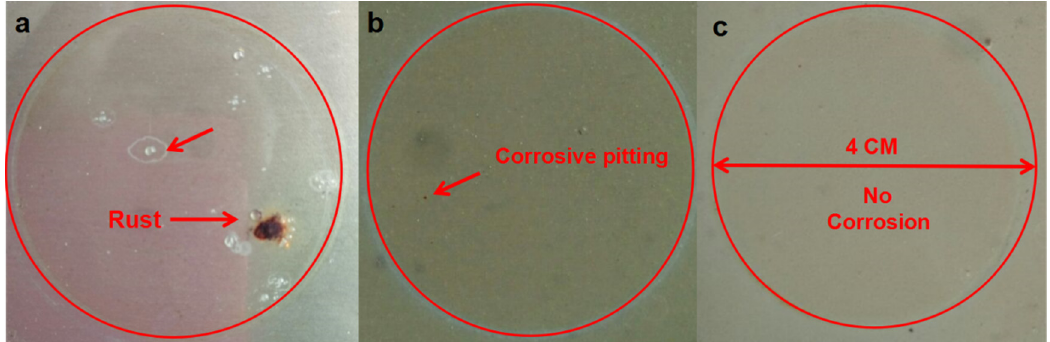
Figure 7. Surface topography of ( a ) pure epoxy coating, ( b ) OTiO 2 (w) epoxy coating, and ( c ) iETiO 2 (w) epoxy coating after ESI measurement.